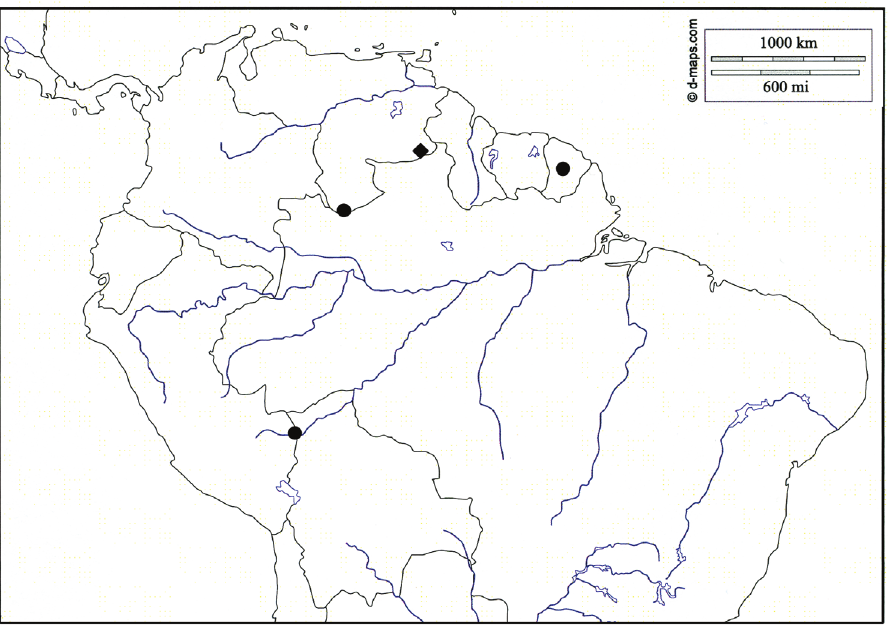
Figure 6. Map of northern South America showing collection localities of Amazonopsis theranyi sp. n. (circles) and A. camachoi sp. n. (diamond) (map template provided by d-maps of Trets,